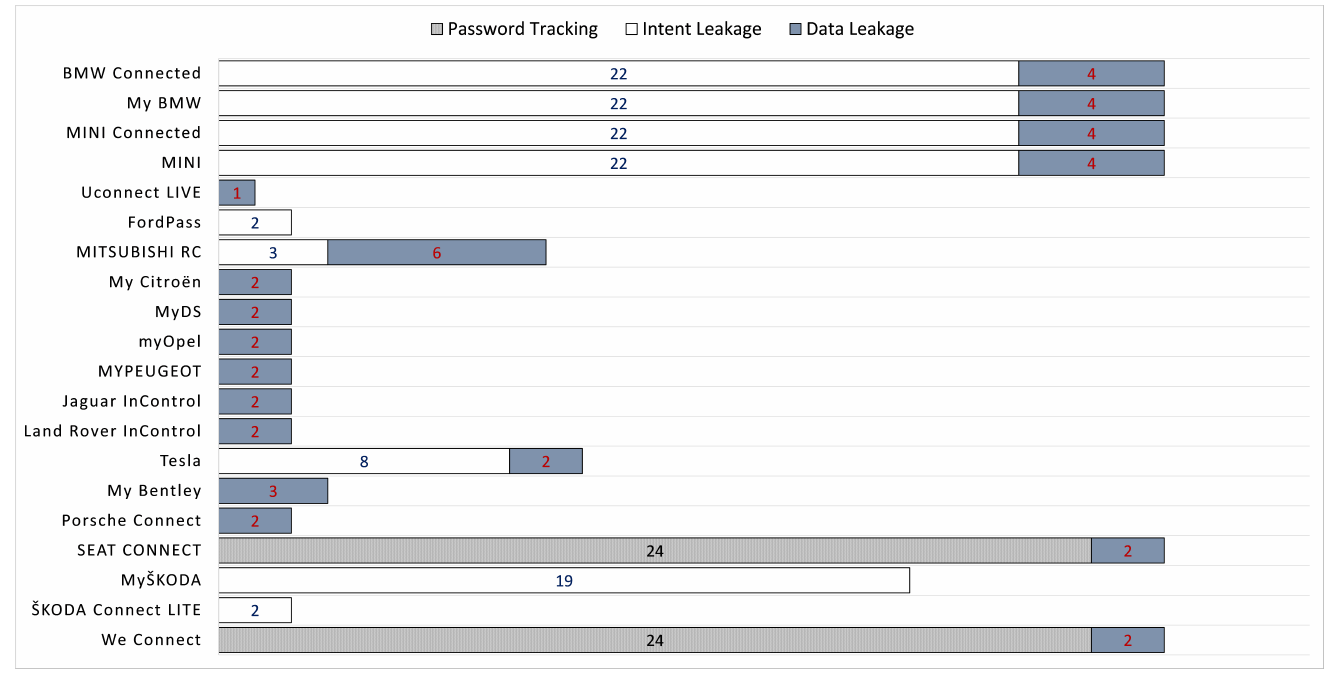
Figure 3. Issues identified through taint analysis. The numbers inside the bars designate the amount of issues per